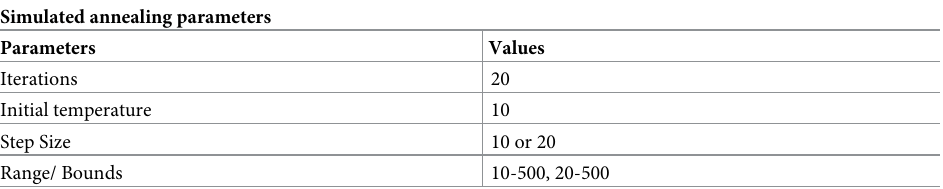
Table 1. This table shows the hyper-parameters for simulated